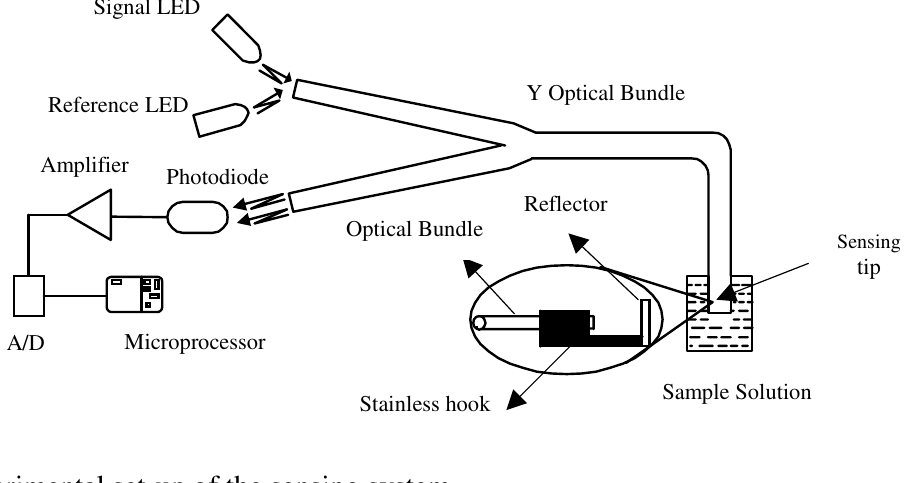
Figure 2. Experimental set-up of the sensing